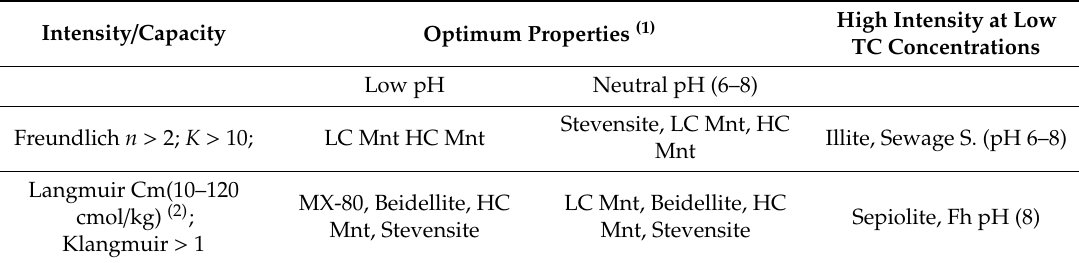
Table 5. Classification of materials for their adsorption intensity and capacity (see